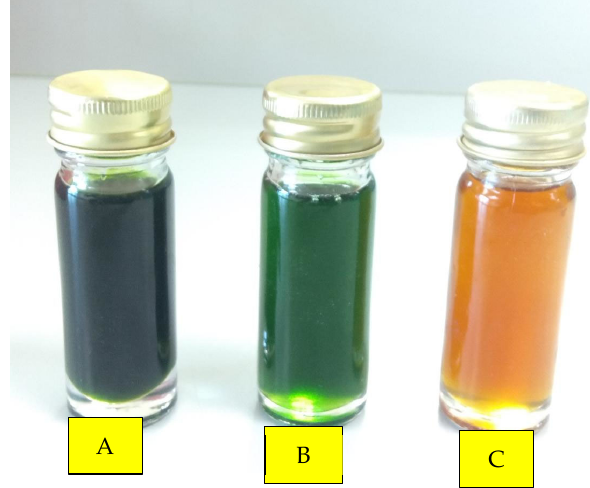
Figure 2. The green honey and common brown honey originating from Banggi Island, Sabah. Processed green honey ( A ) is darker than raw green honey ( B ). A common brown colour of raw Tualang honey ( C ).